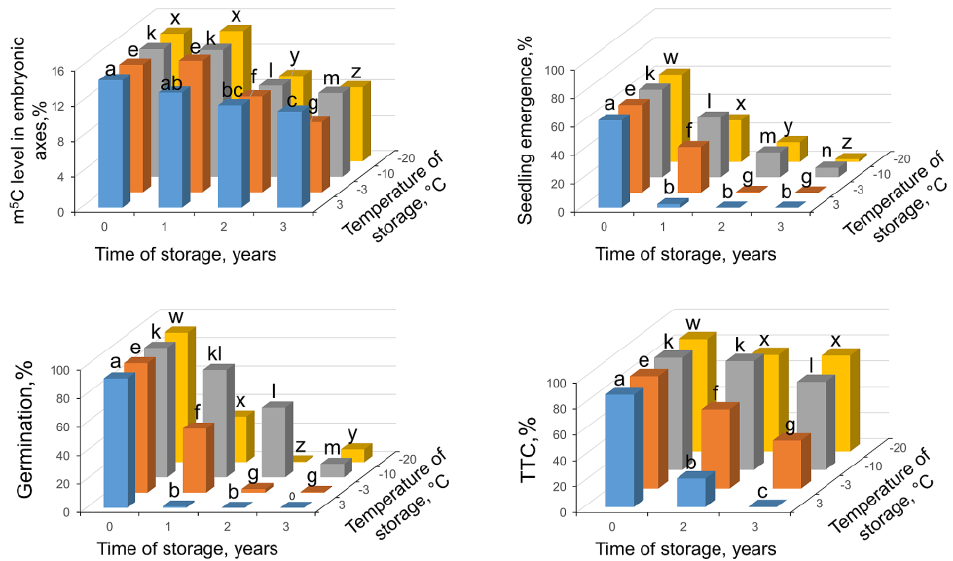
Figure 5. Changes in m 5 C in embryonic axes, seedling emergence, germination capacity, and viability in measured TTC assay in Fagus sylvatica L. seeds desiccated to MC of 13.4% and subsequently stored at four various temperatures (3, − 3, − 10, − 20 ◦ C) for one, two, and three years. Values labeled with different letters are significantly different at p ≤ 0.05, ANOVA, Tukey test. Data represent the mean ± se ( n = 5).